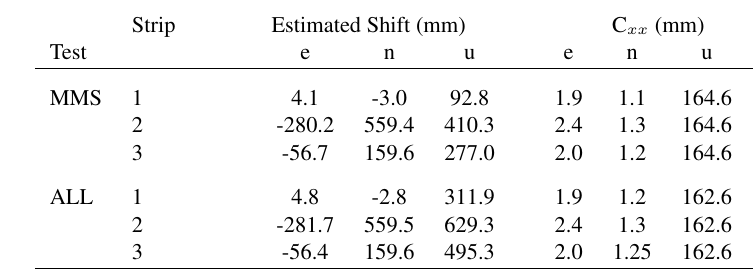
Table 8: MMS test results